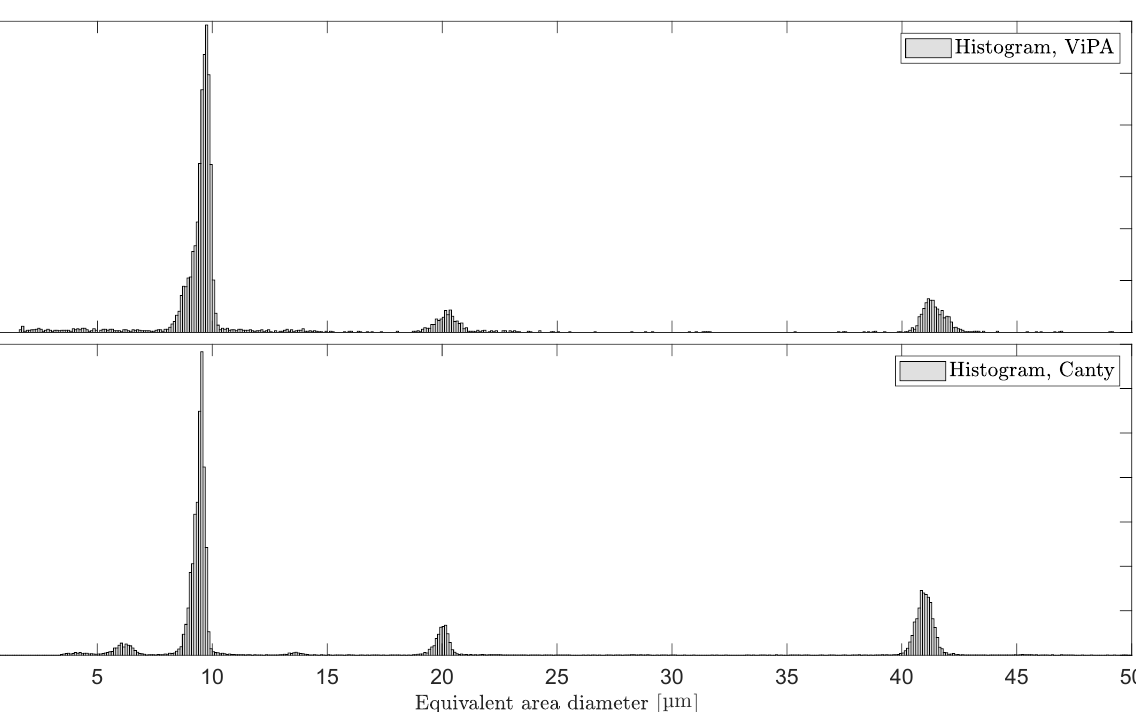
Figure 10. Three known particle sizes were measured simultaneously by C 2 and C 3 . The mean and sample standard deviation are listed in Table